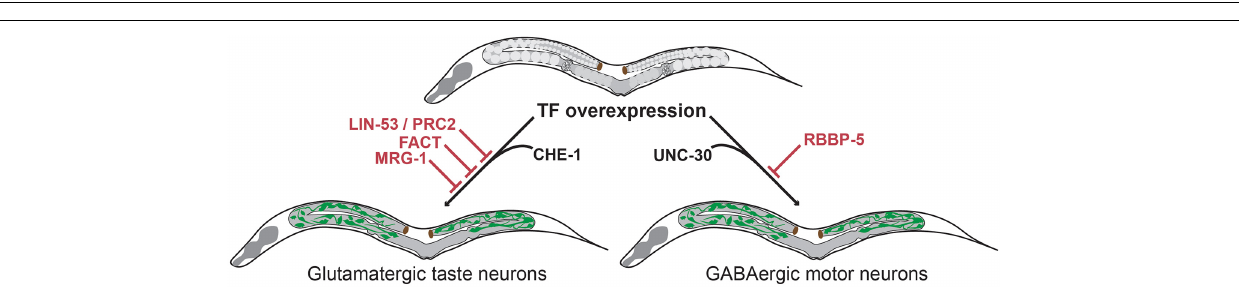
FIGURE 3 | Transcription factor-induced germ cell reprogramming to neuronal fates. The histone chaperone LIN-53 prevents reprogramming of germ cells into glutamatergic taste neurons (known as ASE) upon overexpression of the Zn-finger TF CHE-1 (Tursun et al., 2012). LIN-53 cooperates with the Poly Comb Repressive Complex 2 (PRC2) to prevent neuronal induction in the germline (Patel et al., 2012). The heterodimeric histone chaperone FACT (Kolundzic et al., 2018) and the chromodomain protein MRG-1 block germ cell conversion to glutamatergic neurons (Hajduskova et al., 2019). The methyltransferase complex member RBBP-5 blocks germ cell reprogramming to GABAergic neurons upon UNC-30 TF-induction (Kazmierczak et al.,